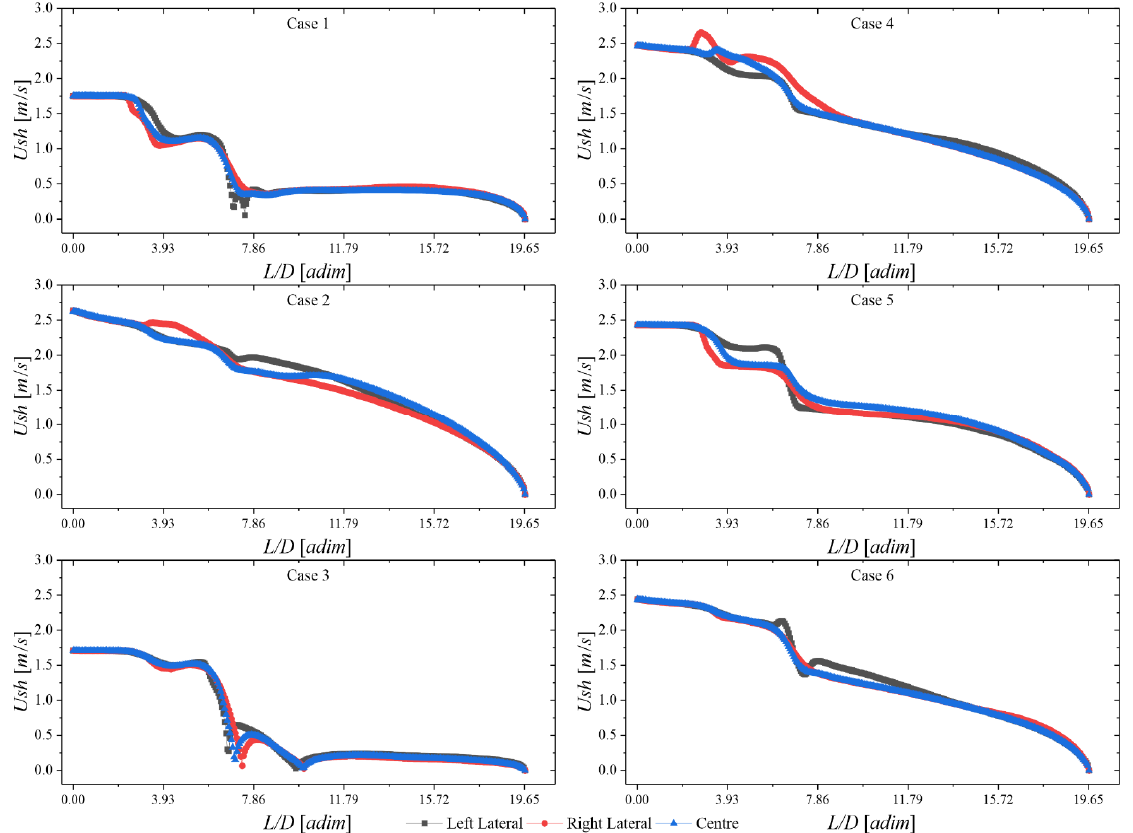
Figure 7. Shear velocity values over the three different markers of the distinct